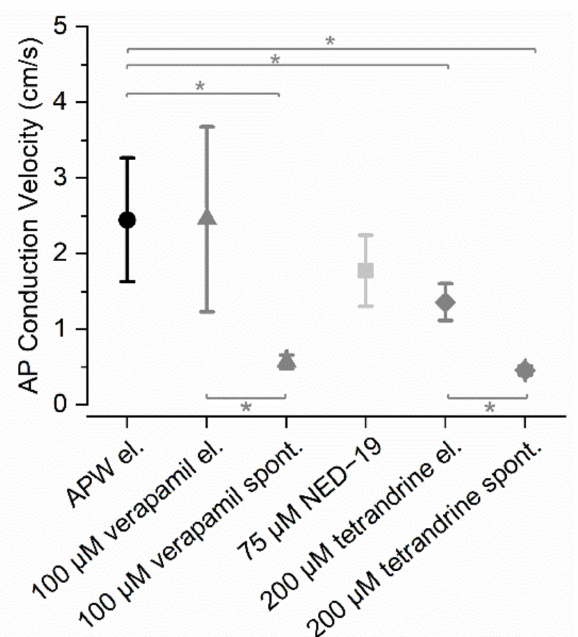
Figure 2. Average AP conduction velocities in N. obtusa in the standard solution APW and after exposure to the drugs: 100 µ M verapamil, 75 µ M NED-19, and 200 µ M tetrandrine. APs were stimulated electrically unless a drug evoked a spontaneous AP train. Asterisks indicate significant differences, n = 4 −